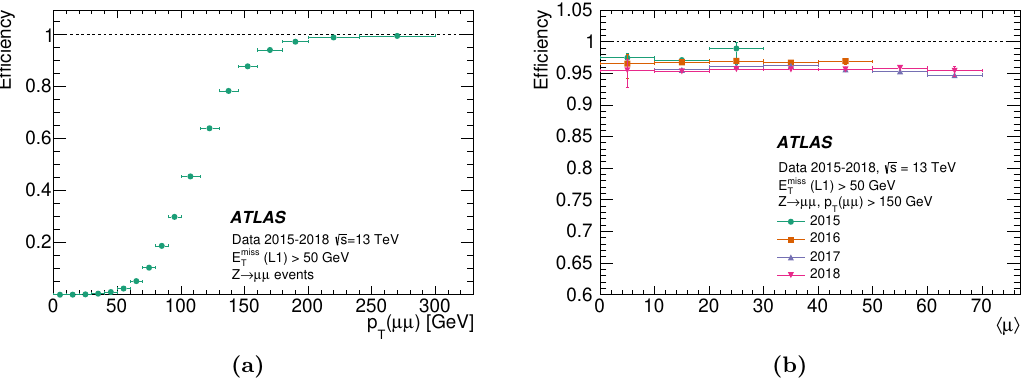
Figure 3. (a) The L1 E miss trigger e(cid:14)ciency, shown as a function of p T ( (cid:22)(cid:22) ) in Z ! (cid:22)(cid:22) events. (b) T The e(cid:14)ciencies in the plot are shown for events satisfying a Z ! (cid:22)(cid:22) selection and with p T ( (cid:22)(cid:22) ) larger than 150 GeV vs pile-up for each of the four years of data taking. The uncertainties are